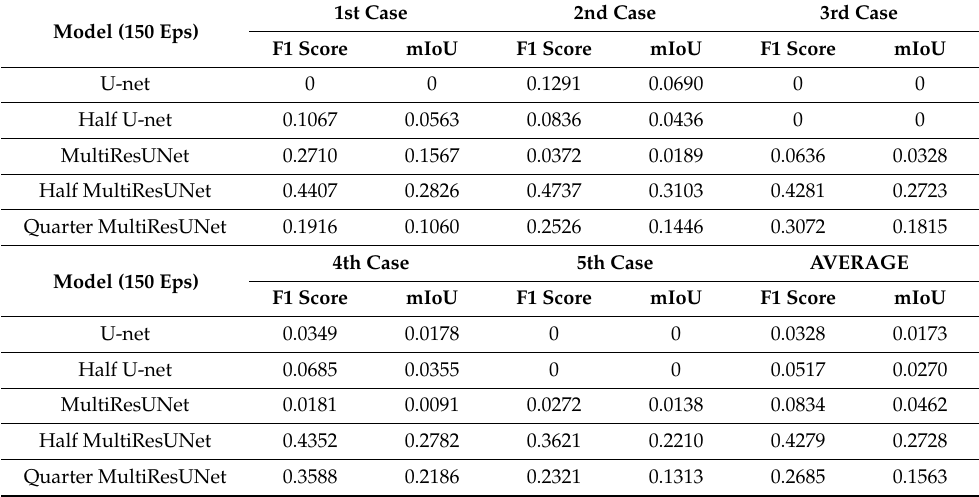
Table 2. F1 score and mIoU of five neural